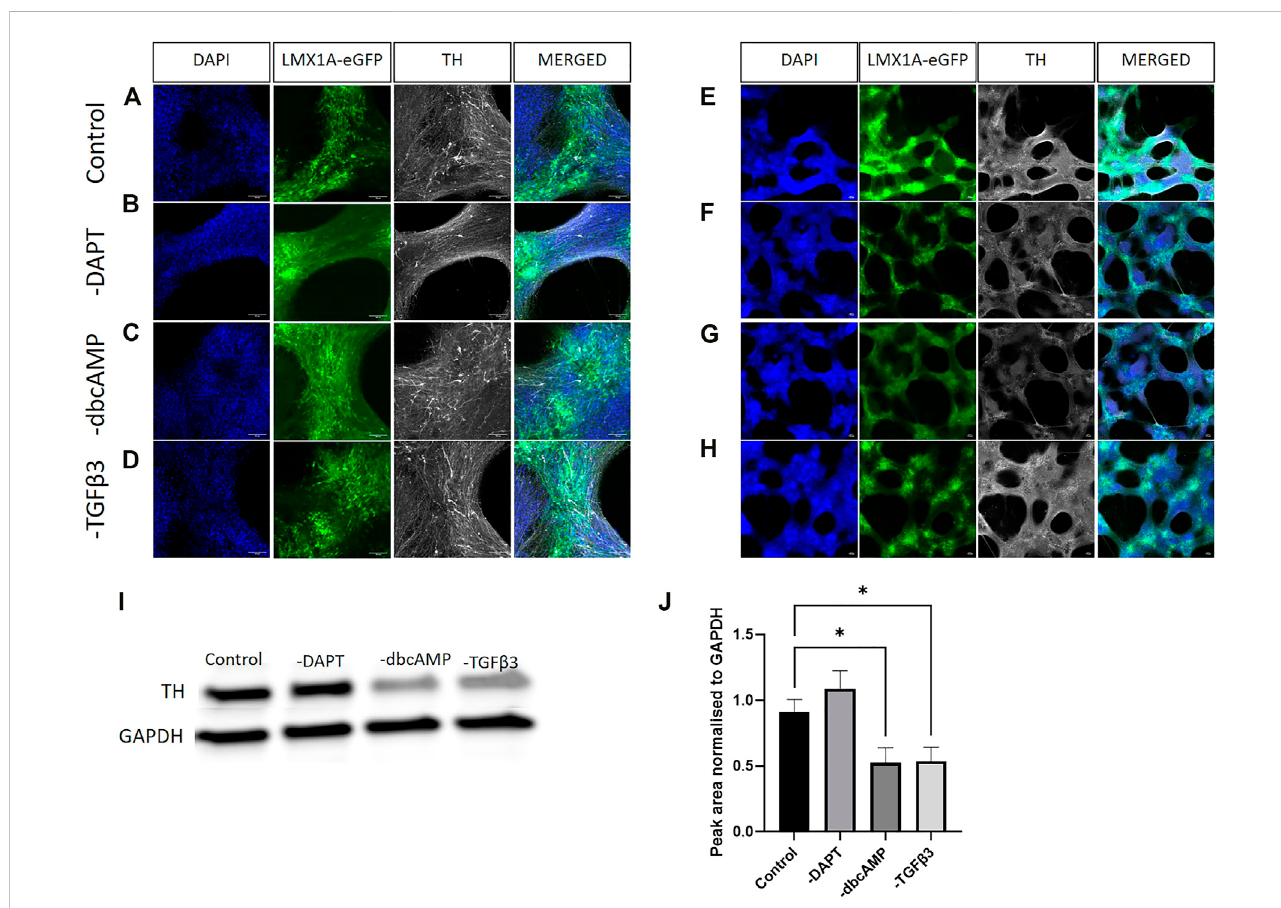
FIGURE 5 Immunolabelling of tyrosine hydroxylase in LMX1A-eGFP cultures. Panels [ (A – D) , ×20 objective) show, from left to right, DAPI nuclear labelling (blue), LMX1A-eGFP fl uorescence (green), TH (white) in control (panel A), and after removal of DAPT [panel (B) ], dbcAMP [panel (C) ] and TGF β 3 [panel (D) ], respectively. Panels (E – H) show corresponding low power images (×4 objective). Scale bar indicates 100 μ m. Panel (I) shows typical Western blotting, while panel (J) shows quanti fi cation of TH ( n = 3) following the removal of additives. Bar graphs show mean +/- s. e. mean; * = p <